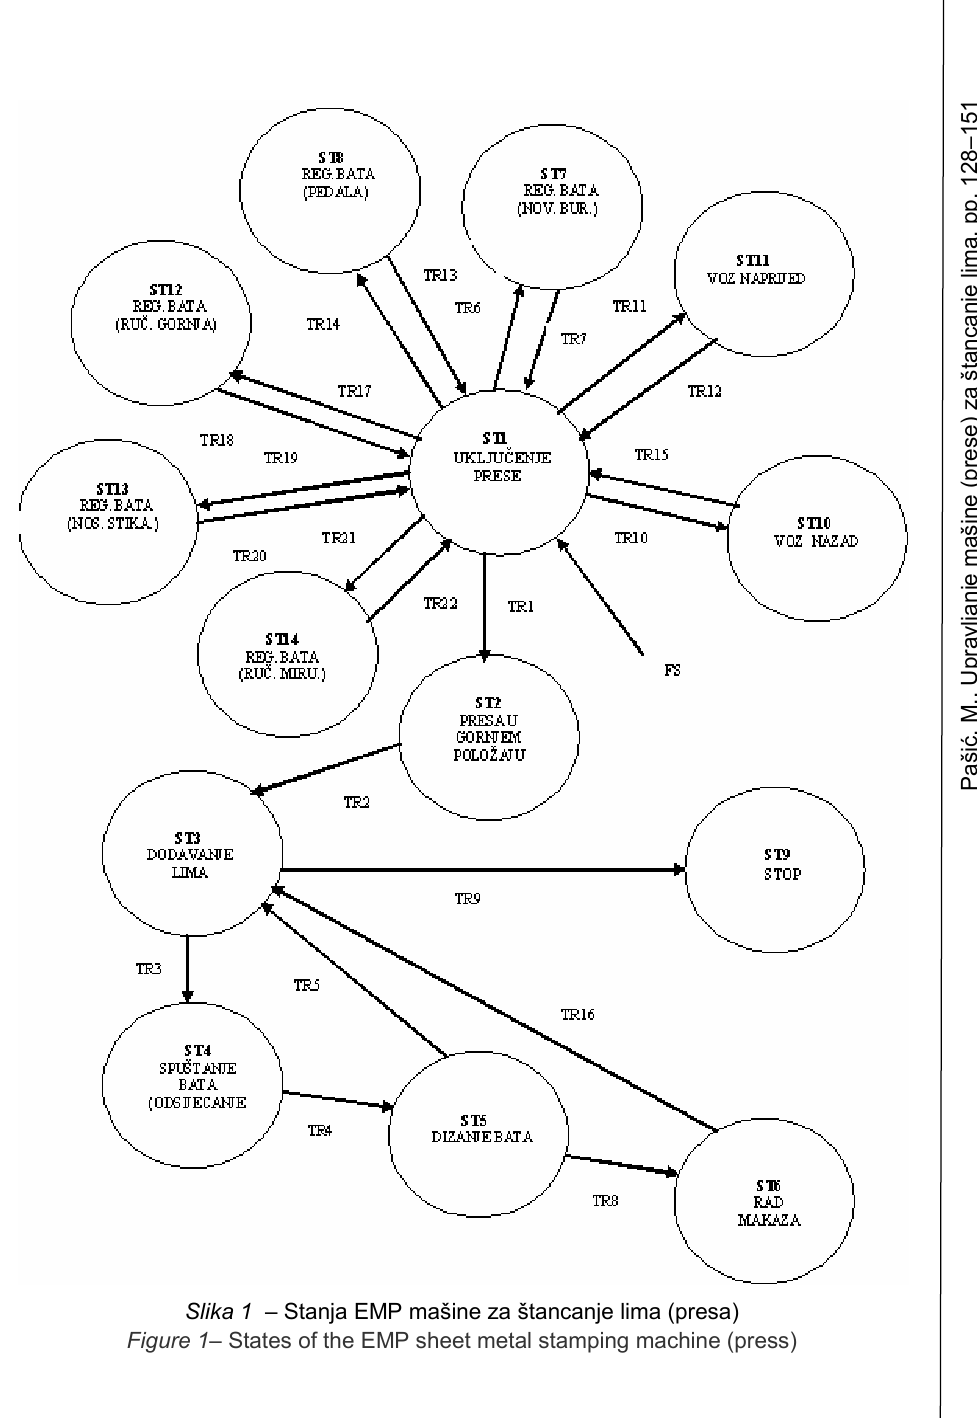
Figure 1– States of the EMP sheet metal stamping machine